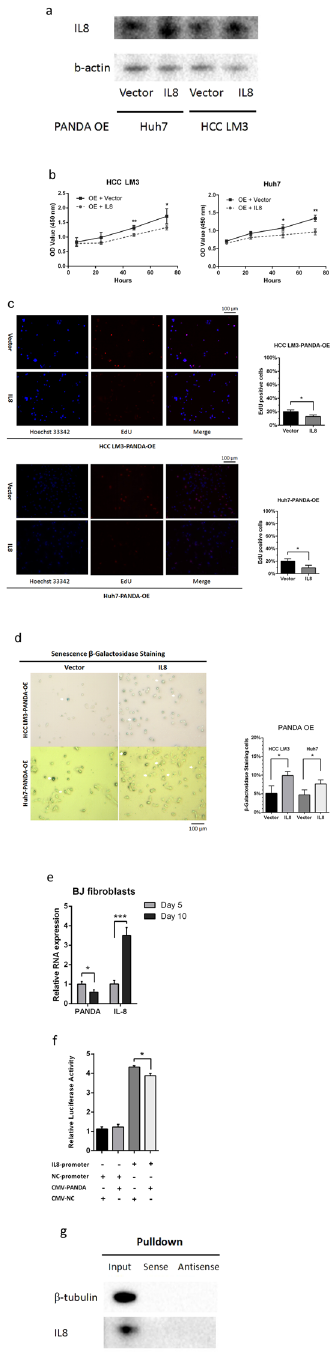
Figure 6. Overexpression of IL8 rescues PANDA-mediated phenotype. ( a ) Effects of overexpression of IL8 in HCC LM3-PANDA-OE and Huh7-PANDA-OE cells by plasmid were confirmed by western blots. The corresponding full-length blots were exhibited in Supplementary Figure 3. ( b ) PANDA-overexpressed cells transfected with IL8 plasmid had reduced OD values (450 nm) at 24, 48, 72 hours compared with those with empty vector. ( c ) For EdU assay, PANDA-overexpressed cells transfected with IL8 plasmid had less percentage of EdU positive cells. ( d ) For in vitro senescence associated β -galactosidase staining, PANDA-overexpressed cells transfected with IL8 plasmid had more blue stained cells. ( e ) RNA expression levels of PANDA and IL8 were analyzed in BJ fibroblasts at indicated time after transfected with NRas G12V plasmid. ( f ) The reporter activity of IL8 promoter in 293 T with or without overexpression of PANDA was determined by dual luciferase reporter assay system. ( g ) Huh7 cell lysates were incubated with in vitro -transcribed biotin-labeled sense or antisense PANDA for RNA pull-down assay, followed by western blot analysis with indicated antibodies. The corresponding full-length blots were exhibited in Supplementary Figure